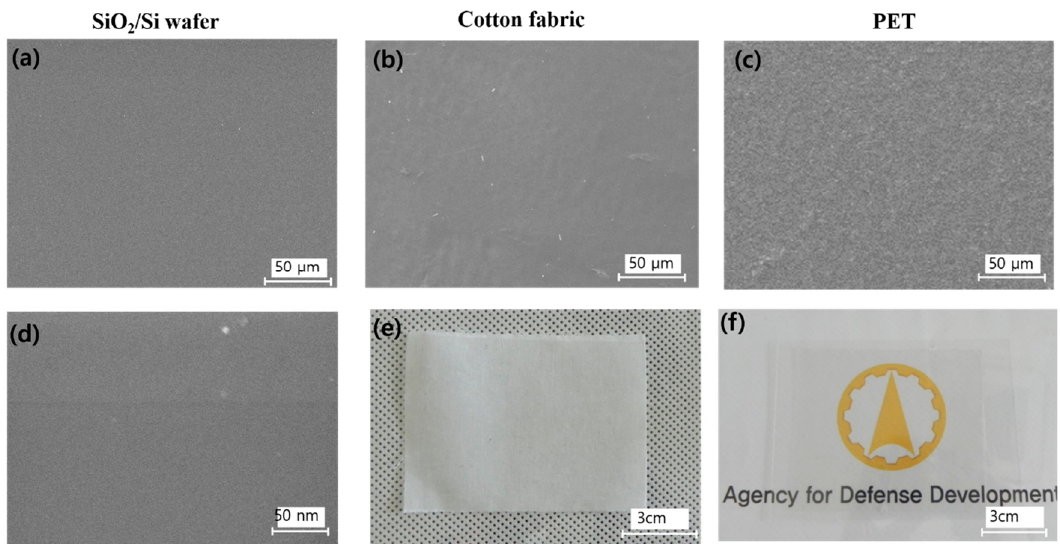
Figure 2. Characterization of graphene on different flexible substrates. ( a , d ) SEM images of graphene indirectly transferred on a SiO 2 /Si wafer, ( b , e ) SEM and optical images of graphene on cotton fabric, and ( c , f ) SEM and optical images of graphene on PET.